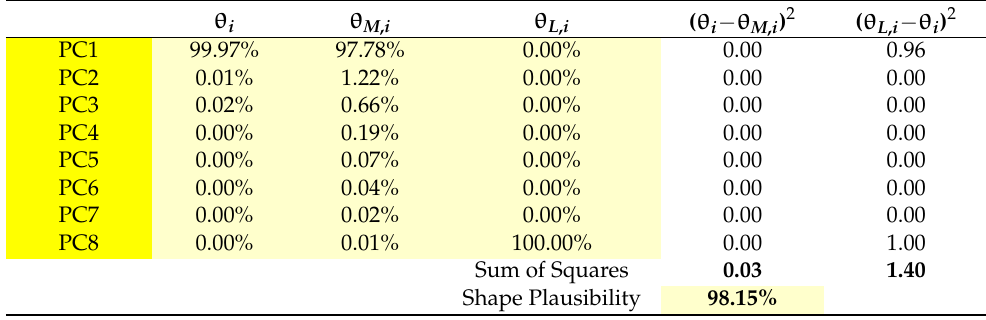
Table A4. Shape plausibility of actual yield curve evolution on 13 March 2020. Source: Own